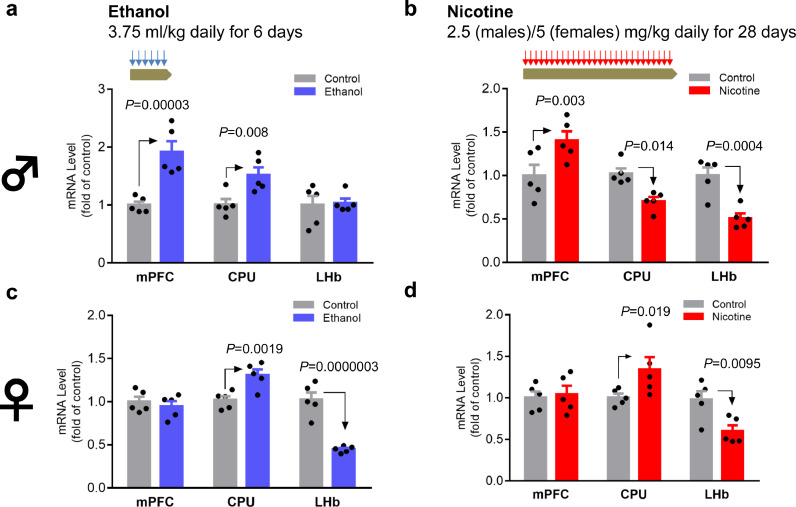
Tissue-dependant regulation of Ppp1r12b mRNA by chronic ethanol (a,c; blue) or nicotine (b,d; red) exposure in male (a,b) or female (c,d) mice. Procedures for chronic treatments are indicated on top of whole figure, the symbol♂ for male and ♀ for female are showed on left of whole figure. Note that males and females had different nicotine doses; the t-tests-based exact P values of <0.05 are showed in graphs; 3-way ANOVA implied significant ethanol interaction with sex (P<0.0001) (n = 5/group).